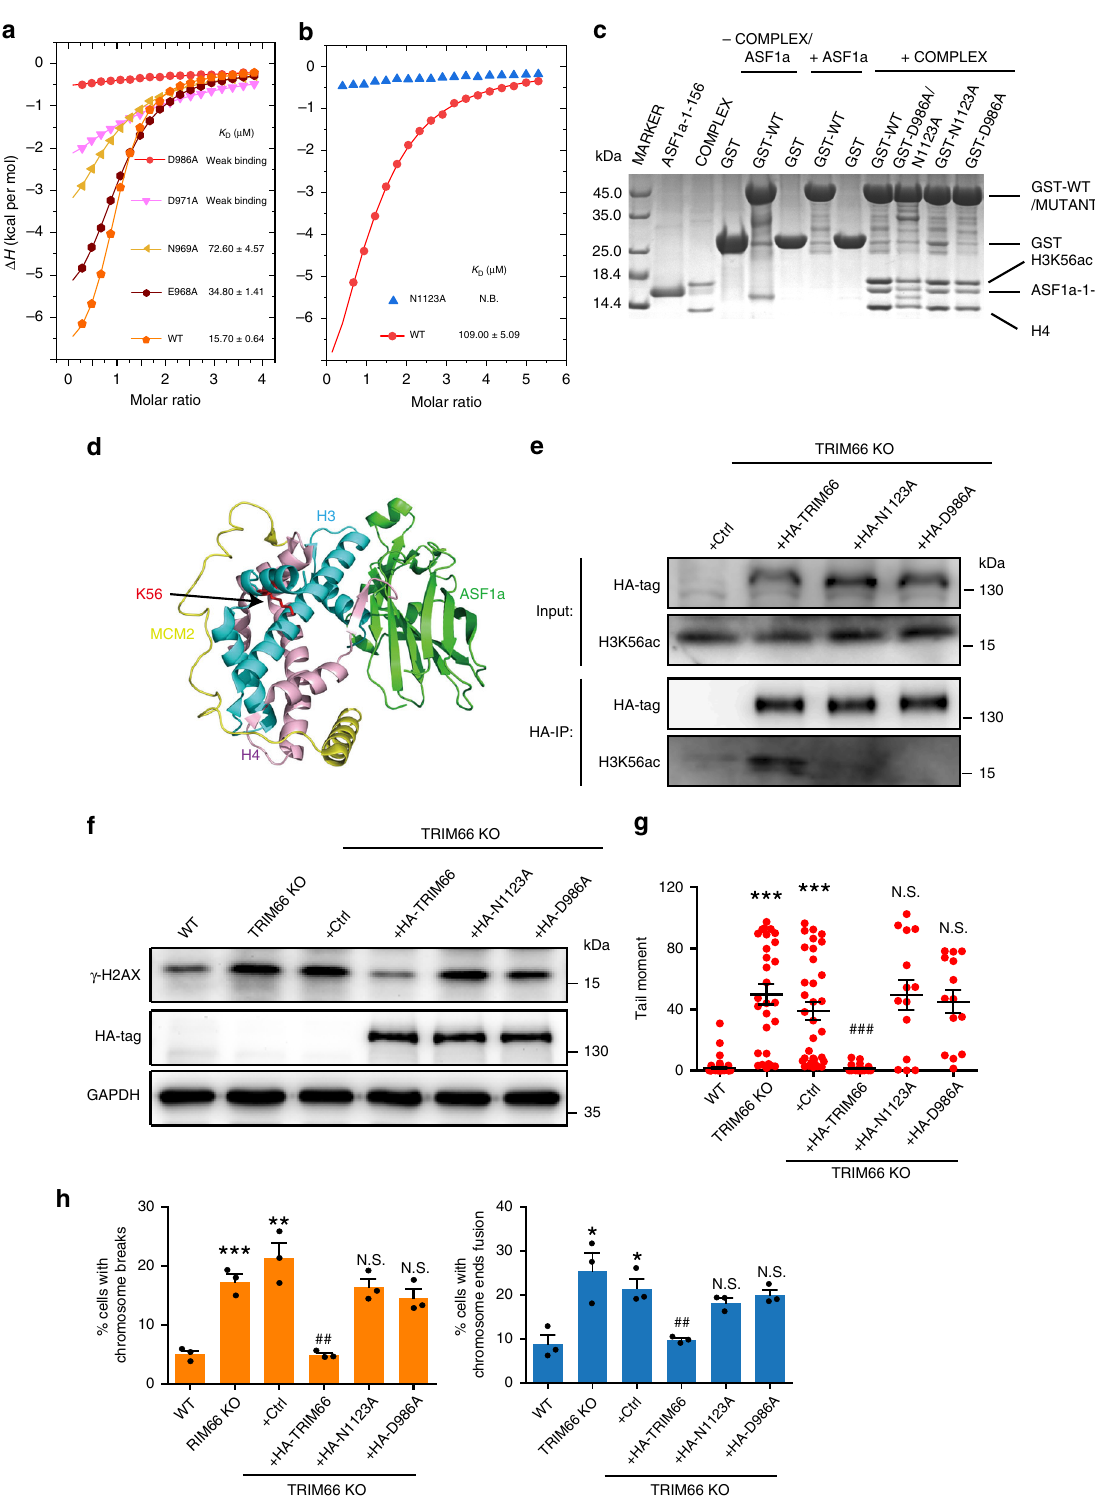
ligated H3R2me0K4me0-H3K56ac peptide and the H3K56ac-H4 TRIM66 could bind to H3K56ac, whereas TRIM66 mutants dimer in a combinational manner. apparently lost their ability to bind to H3K56ac (Fig. 4e). Further, we reconstituted HA-tagged WT or mutant TRIM66 Meanwhile, we analyzed the colocalization of H3K56ac and (N1123A and D986A) in TRIM66-KO ESCs and veri fi ed the TRIM66-WT or mutants in ESCs. Our results found that, unlike interaction between TRIM66 and H3K56ac in ESCs by co- the N1123A and D986A mutants, the WT TRIM66 displayed fi ne immunoprecipitation (Co-IP). Our results revealed that WT colocalization with H3K56ac in the nucleus of ESCs by NATURE COMMUNICATIONS| (2019) 10:4273